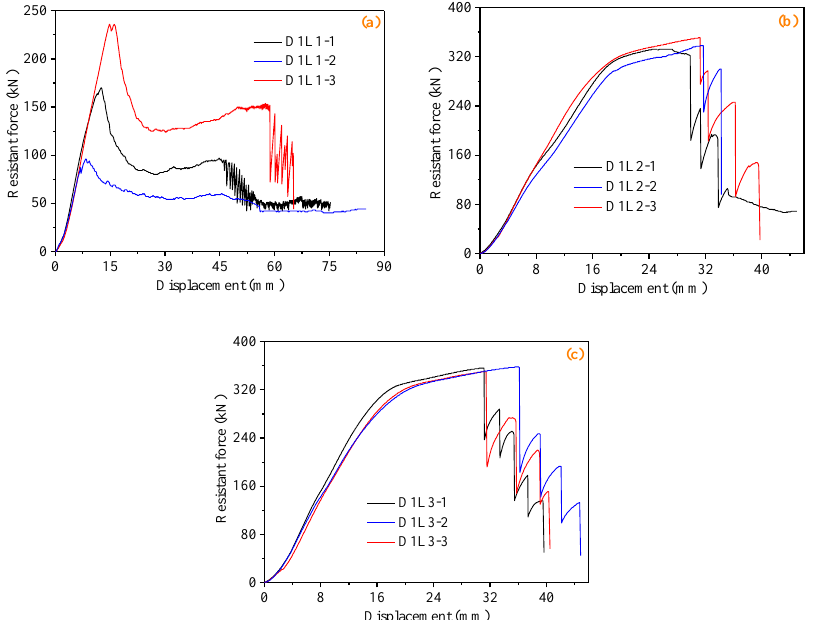
Figure 6. Mechanical response of flexible bolts with different Ø30 mm locking casing lengths: ( a ) 100 mm, ( b ) 120 mm, and ( c ) 140 mm.